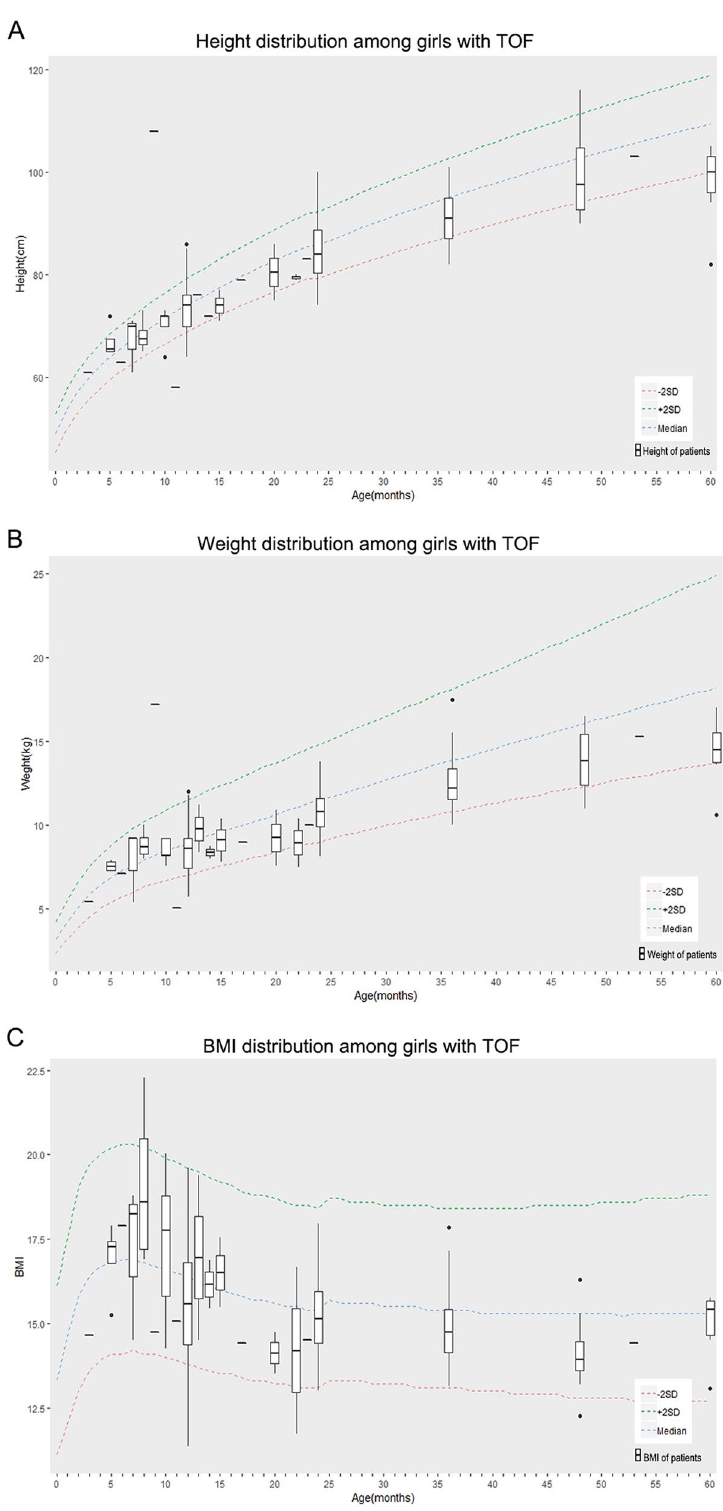
Figure 2. Growth charts for girls with TOF (total number = 124). ( A ) Height for age in TOF patient girls compared with normal chart. ( B ) Weight for age in TOF patient girls compared with normal chart. ( C ) BMI for age in TOF patient girls compared with normal chart. The dotted line represents the world standard value for the height, the green dotted line represents + 2SD, the blue dotted line represents Median, and the red represents -2SD. The data are calculated based on gender and age and calculated in the R Programming